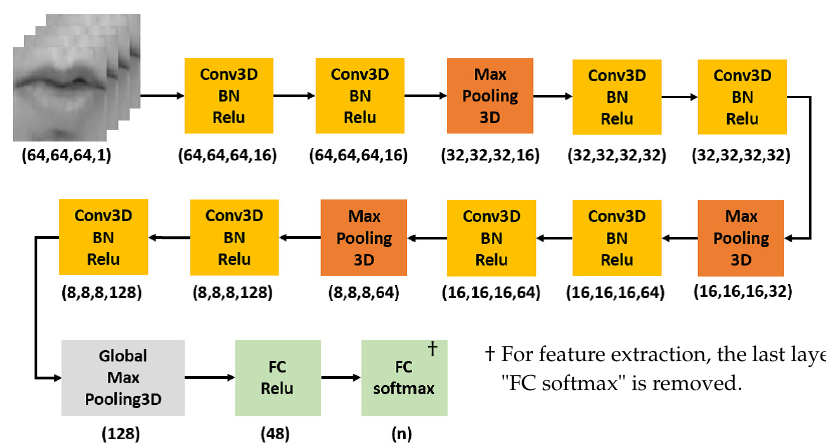
Figure 3. A 3D CNN pre-recognition model for feature extraction. Numbers in parentheses mean data shapes. For example, (64,64,64,1) indicates 64(images) 64 64(size) 1(channel). × ×